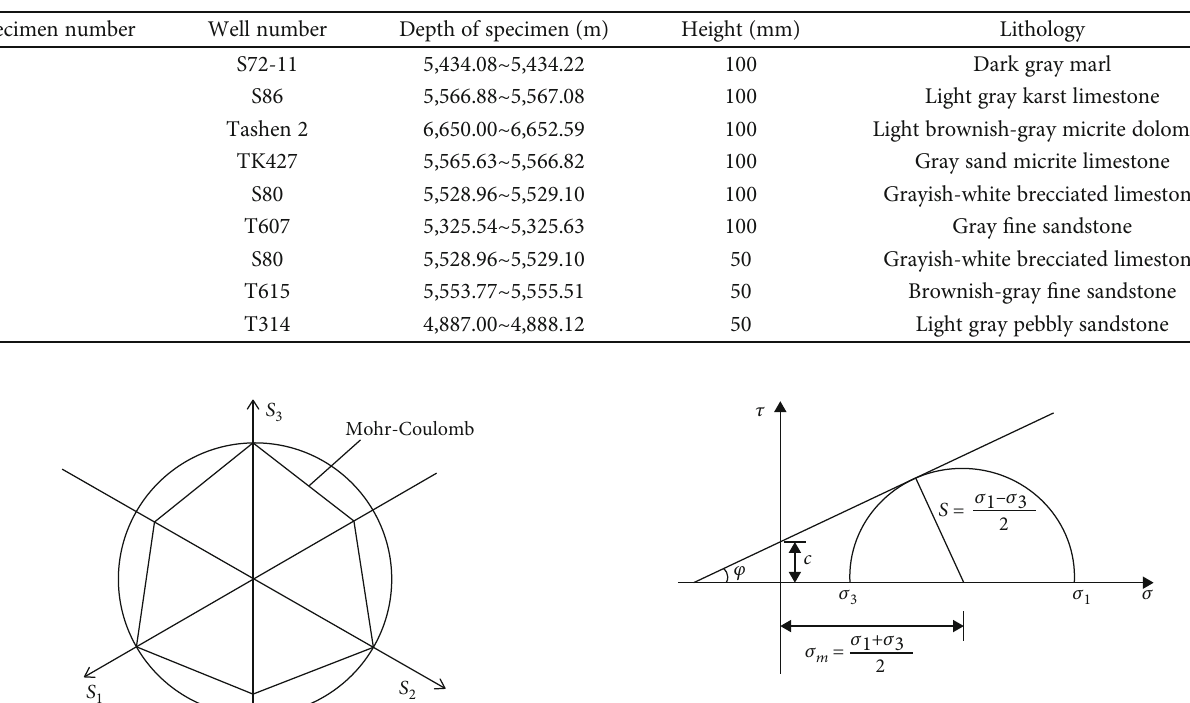
Figure 1: Photographs for core samples. Table 1: Characteristic information of specimens.